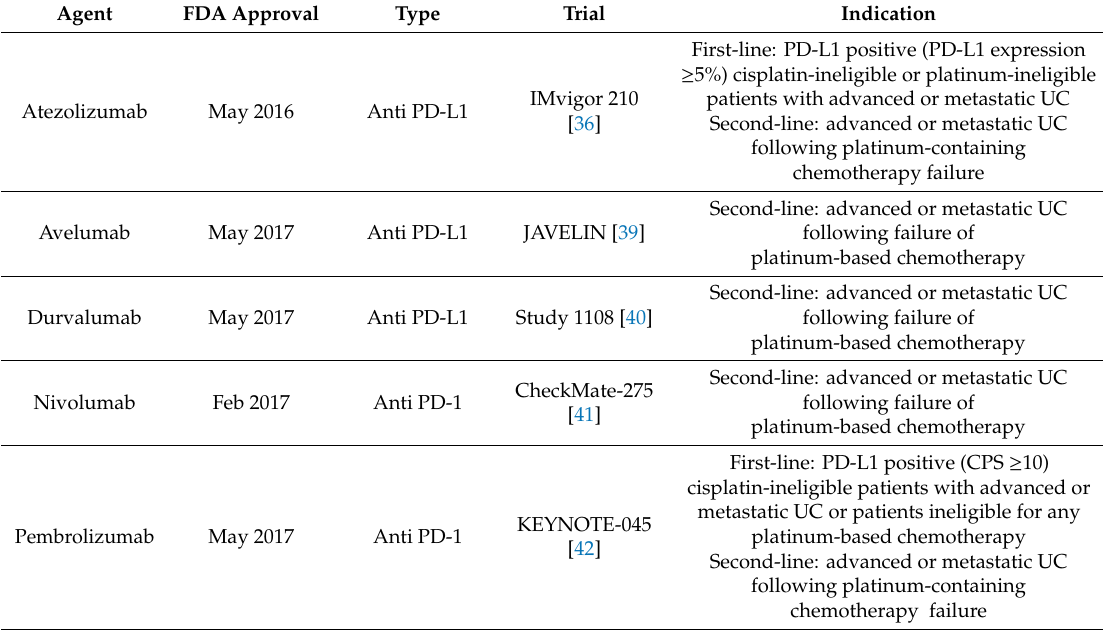
Table 2. Current U.S. Food and Drug Administration (FDA) approved immunotherapies for patients with advanced or metastatic urothelial